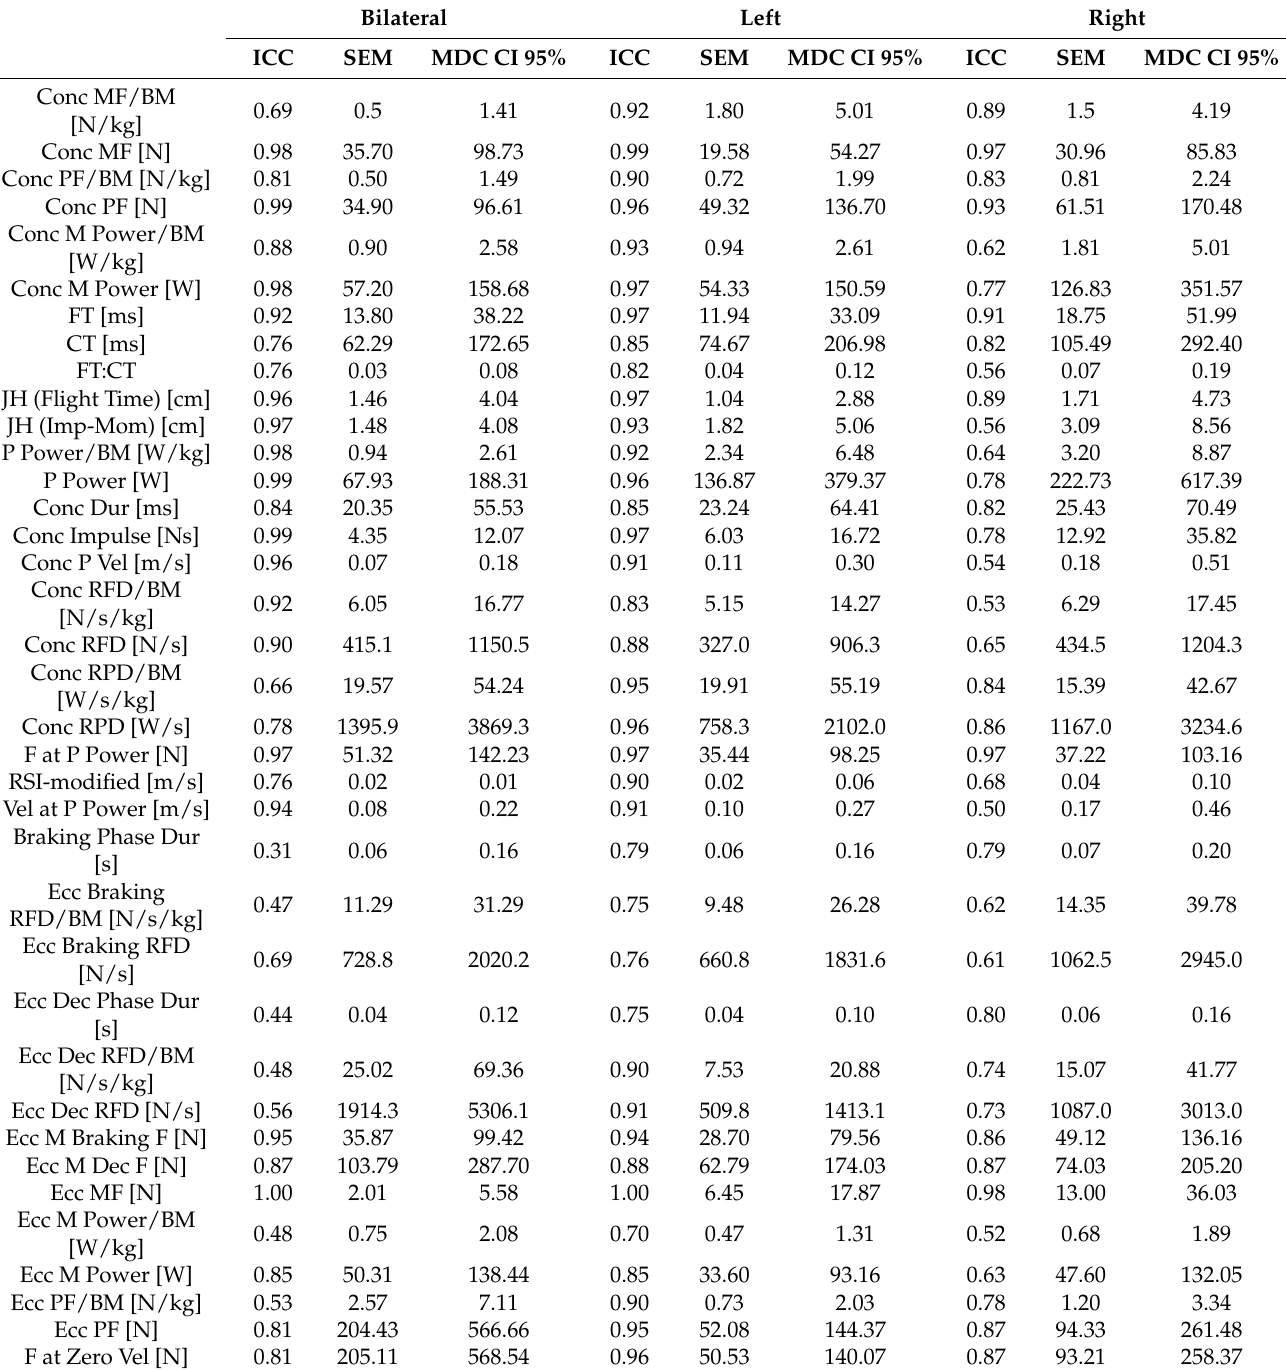
Table 1. Reliability of the bilateral and unilateral CMJ variables. Bilateral Left